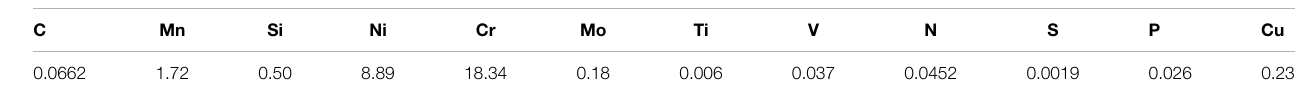
TABLE 1 | Composition of the 304 stainless-steel sheet, Wt.%.